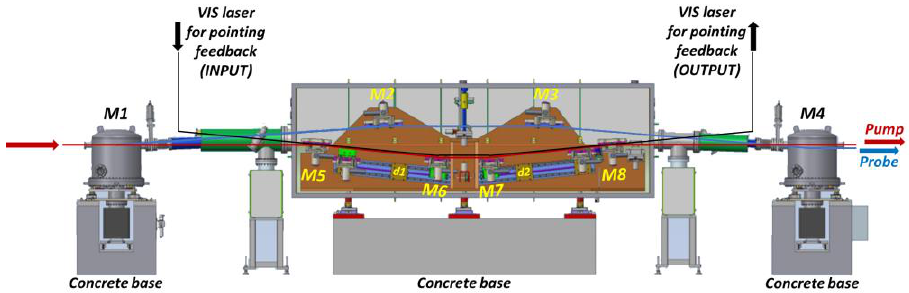
Figure 3. AC/DC mechanical design (side-view). All mirrors and actuators are enclosed into three different UHV chambers. These are all mounted on concrete bases to dampen the vibrations coming from the external environment.